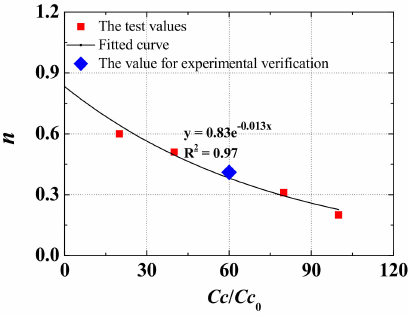
Figure 7. The relationship between the parameter n and cement content Cc